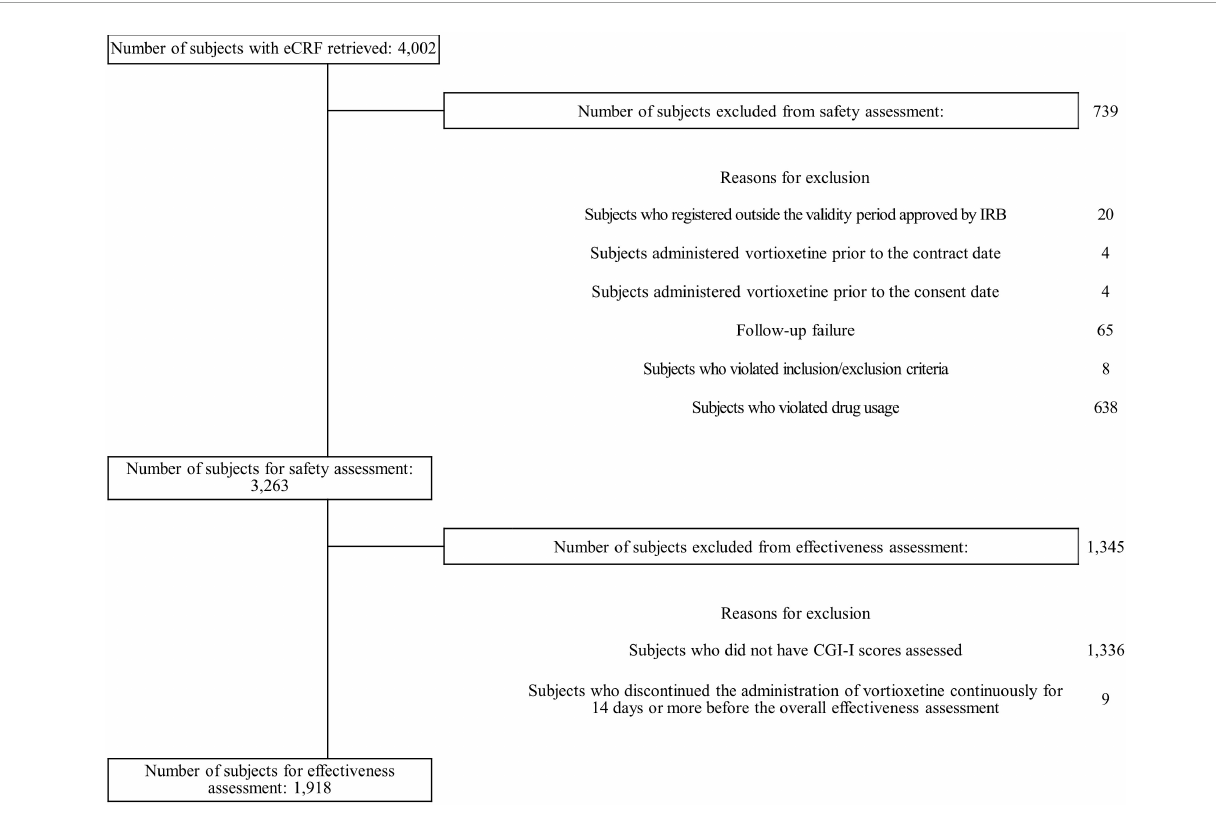
FIGURE1 Patient flow diagram. CGI-I, Clinical Global Impression-Improvement; eCRF, electronic case report form; IRB, institutional review